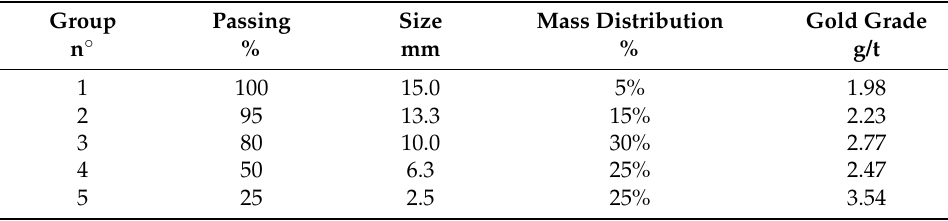
Table 4. Summary of size distribution and gold grade based on particle group.